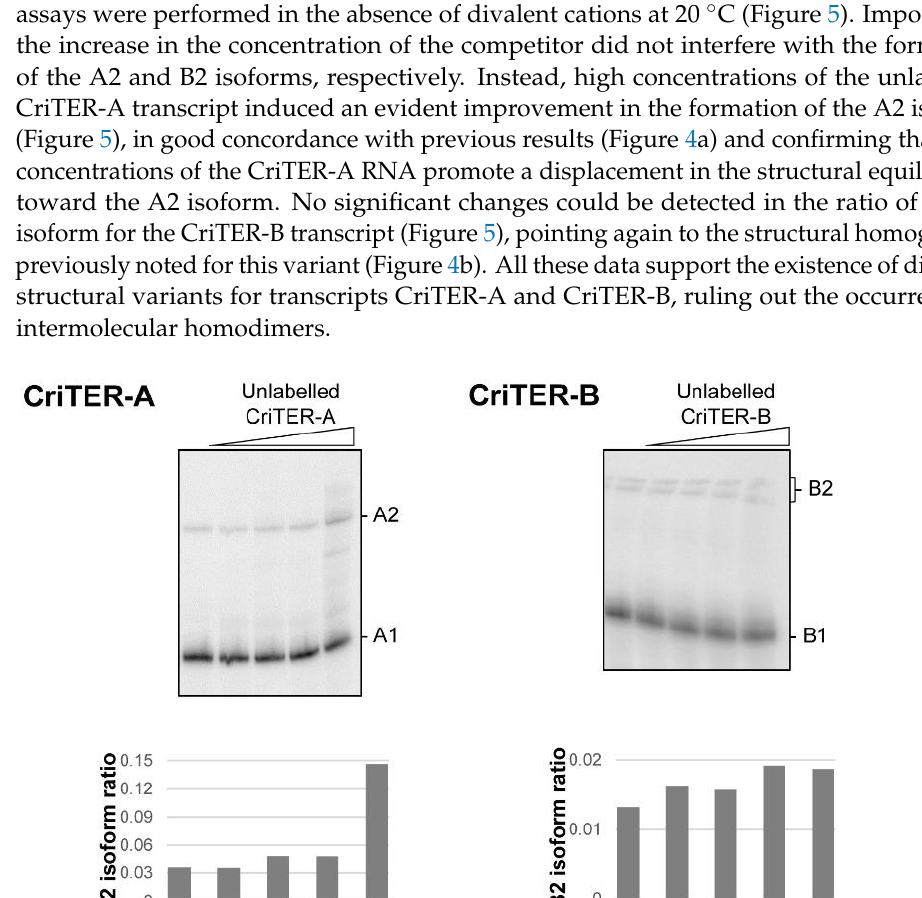
so-called SHAPE reagents